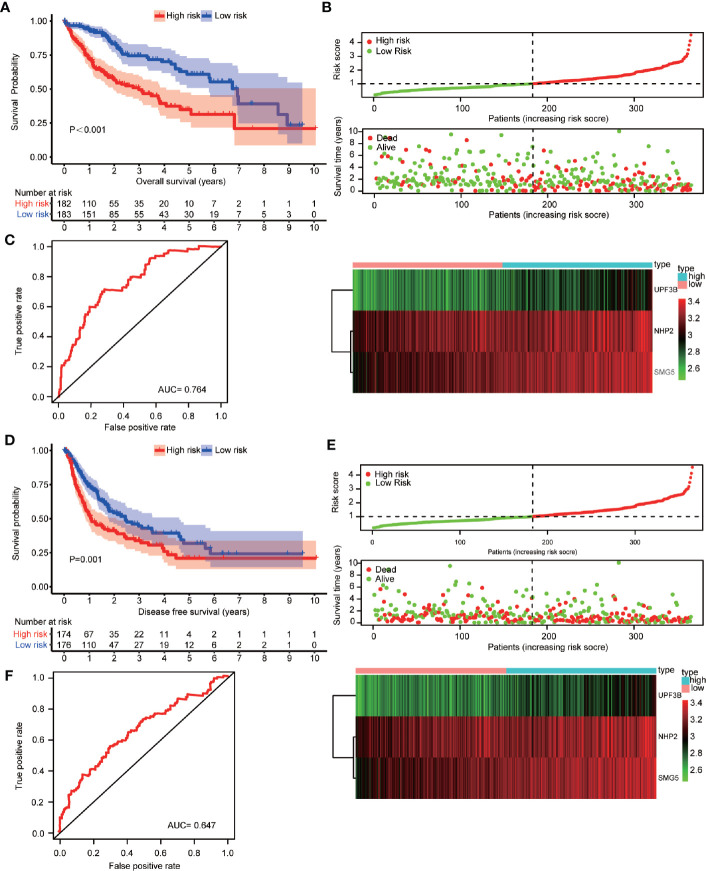
Construction and verification of the prognosis prediction model based on NHP2, UPF3B, and SMG5 and hepatocellular carcinoma (HCC) patients’ overall survival (OS) data. (A) Association of risk classification based on NHP2, UPF3B, and SMG5 with OS in HCC patients were showed. Prognosis was depicted with Kaplan-Meier curves: high risk versus low risk (low risk: 6.37 vs. high risk: 2.981 years; P < 0.001). (B) Samples were sorted by risk score to investigate the association between the expression levels of NHP2, UPF3B, and SMG5 and risk scores. The risk score for OS of HCC patients positively correlated with the expression of NHP2, UPF3B, and SMG5 (r = 0.556, P < 0.001; r = 0.722, P < 0.001 and r = 0.828, P < 0.001, respectively). The horizontal axis represents the samples and the vertical axis represents risk scores (top cartogram), overall survival (middle cartogram), and expression level (bottom cartogram). (C) Receiver operating characteristic (ROC) curves of OS predictors based on NHP2, UPF3B, and SMG5 were showed. (D) Association of risk classification based on NHP2, UPF3B, and SMG5 with disease-free survival (DFS) in HCC patients were showed. Prognosis was depicted with Kaplan-Meier curves: high risk versus low risk (low risk: 2.447 vs. high risk: 1.090 years; P = 0.001). (E) Samples were sorted by risk score to investigate the association between the expression levels of NHP2, UPF3B, and SMG5 and risk scores. The risk score for DFS of HCC patients positively correlated with the expression of NHP2, UPF3B, and SMG5 (r = 0.556, P < 0.001; r = 0.722, P < 0.001 and r = 0.828, P < 0.001, respectively). The horizontal axis represents the samples and the vertical axis represents risk scores (top cartogram), disease free survival (middle cartogram) and expression level (bottom cartogram). (F) ROC curves of DFS predictors based on NHP2, UPF3B, and SMG5 were showed.